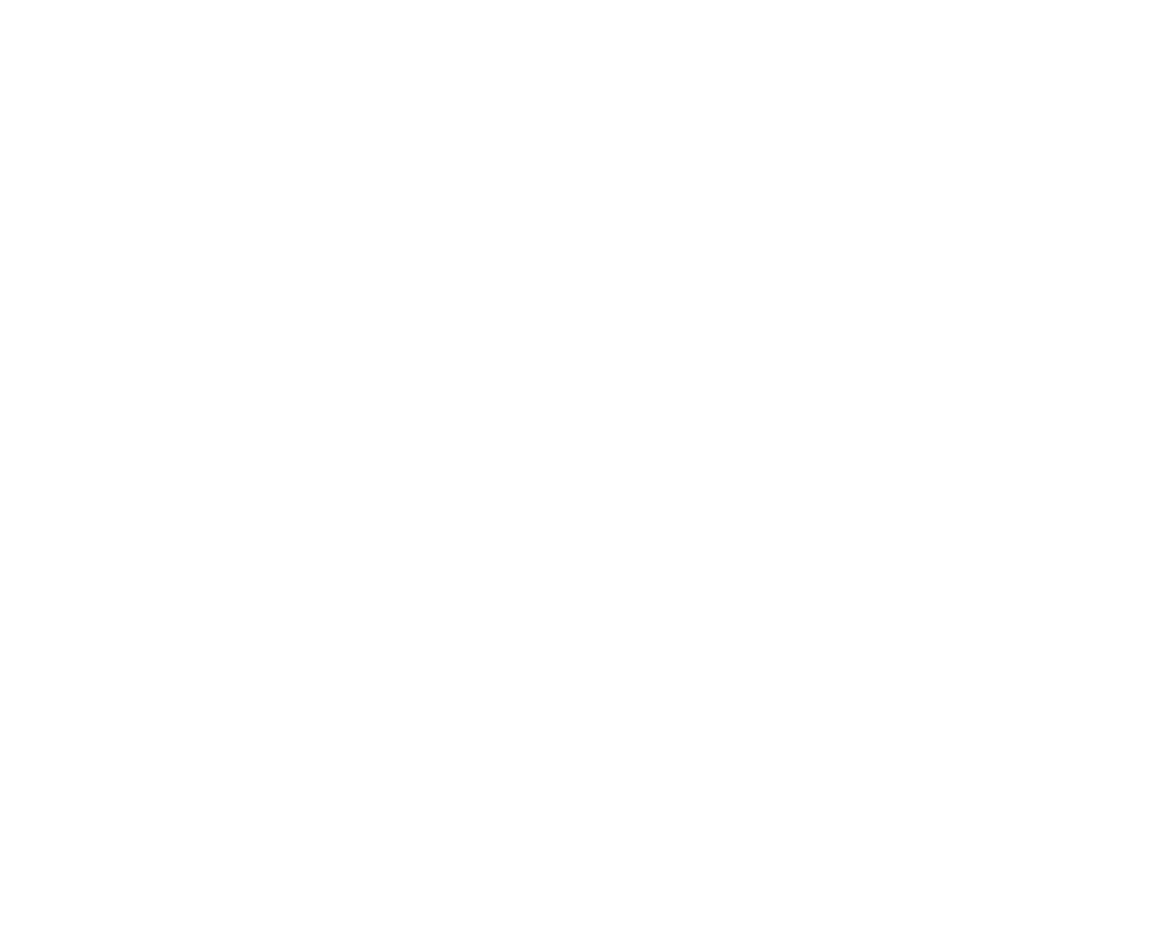
FIGUREA3 |Time-binned linear analysis of extinction behavior in Experiment 3. (A–G) Mean ( ± SEM) number of active lever responses from Days 1–7 of the first extinction training sequence, and (H) the per-subject average ( ± SEM) of cumulative responses, which were categorized into 5-min